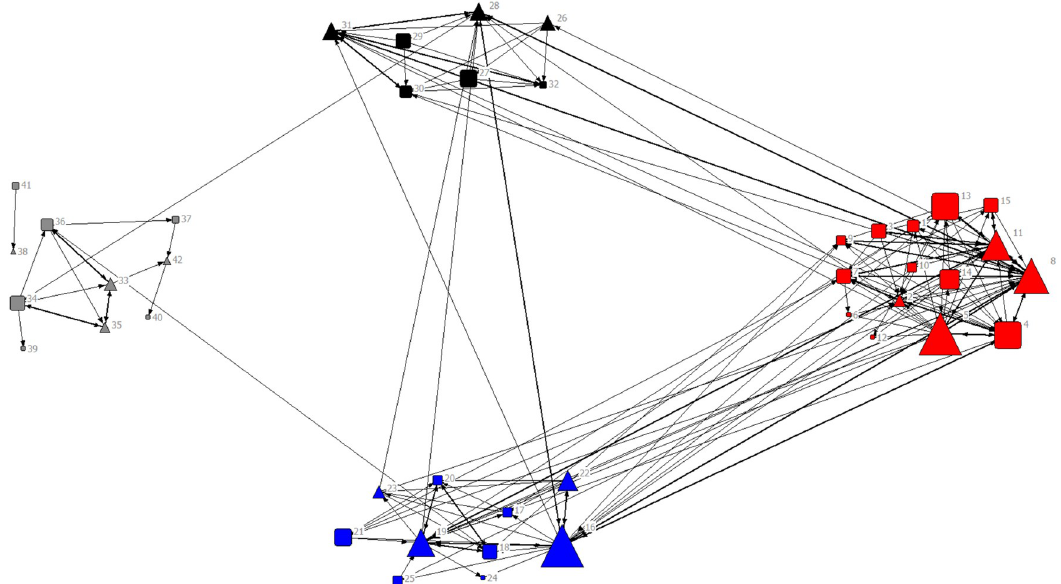
Fig 4. Sociogram of the advice-giving ties. Nodes are agroforestry farmers, and ties are the relationship to give agroforestry advice, with the arrow pointing at the person with whom they gave advice. Node colours represent farmers’ village affiliation (village A–site